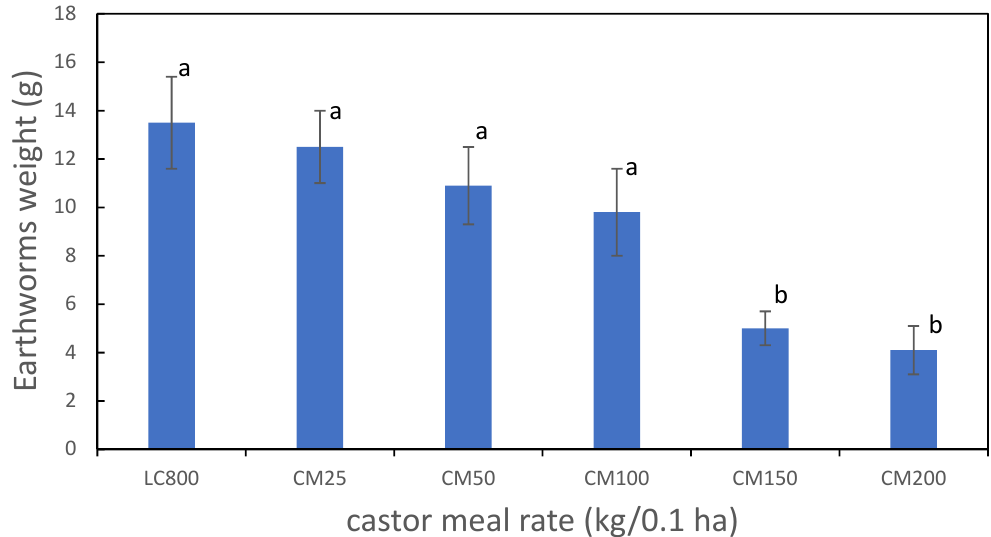
Figure 2. The earthworms variation after the harvesting of Pak Choi ( Brassica chinensis L.) in soil by the treatments of organic fertilizers. (CM 25 , CM 50 , CM 100 , CM 150 and CM 200 represented the rate of castor meal 25, 50, 100, 150 and 200 kg/0.1 ha. LC800 represented the application of livestock compost 800 kg/0.1 ha). The same letters (a, b) in the graphic represent no significant difference with 0.05 level according to Duncan’s multiple range test.